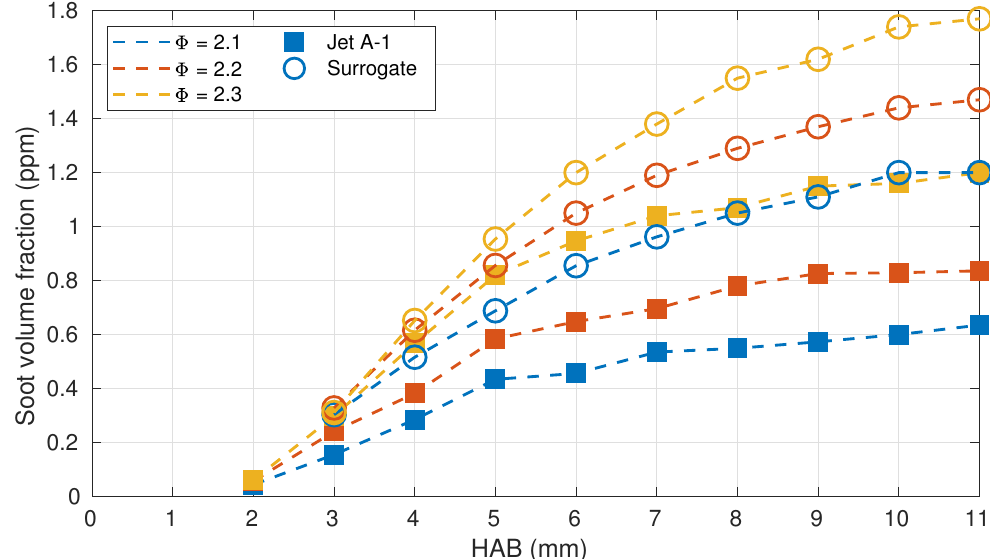
Figure 4. Soot volume fraction profiles measured with laser extinction at 6 cm/s inlet